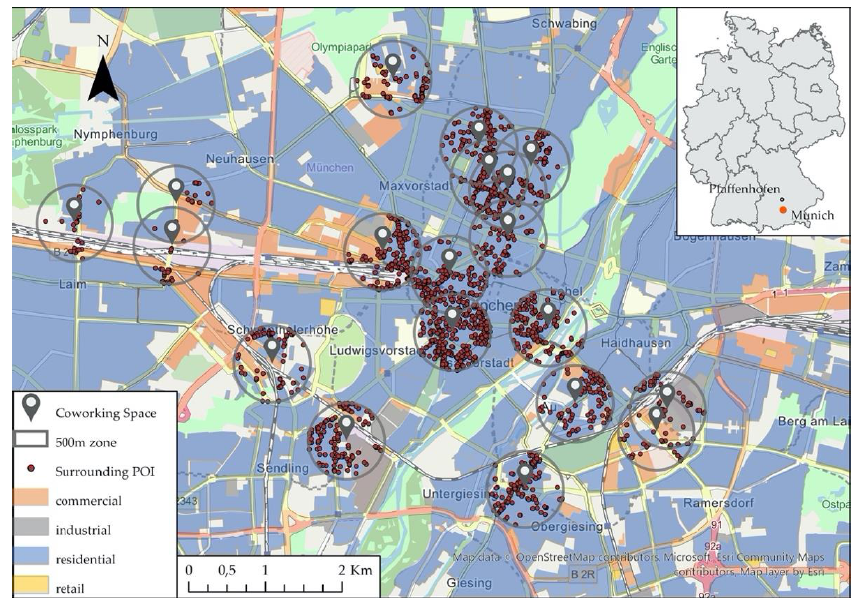
Figure 9. Map of POIs as listed in Table 2 in a radius of 500 m around coworking spaces (CWSs) in Munich (without scale), source: ArcGIS ® software by Esri, OSM, gefabrik.de, coworkingmap.de, © GeoBasis-DE/BKG (2020).